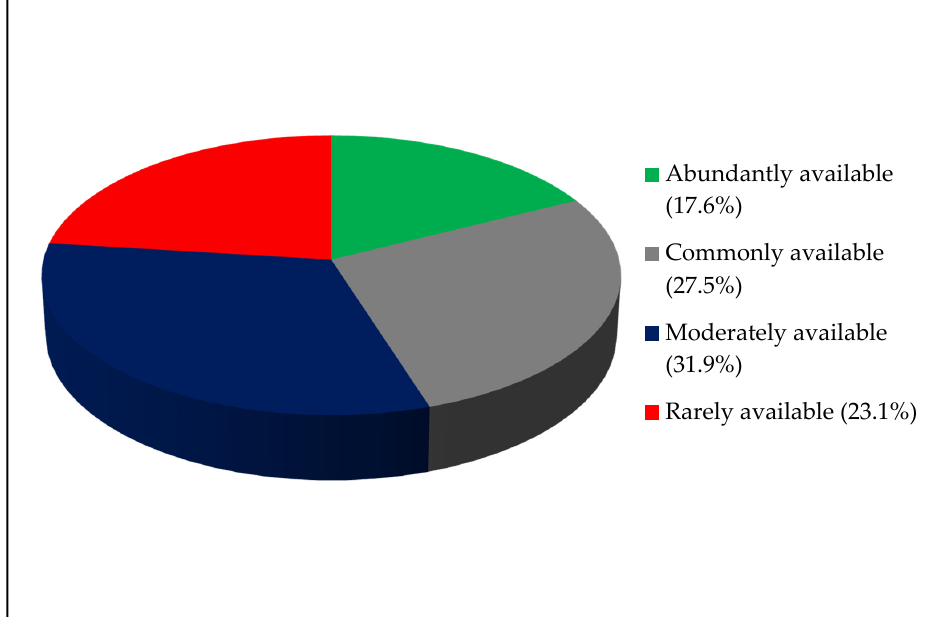
Figure 4. Present fish diversity status of the study area.